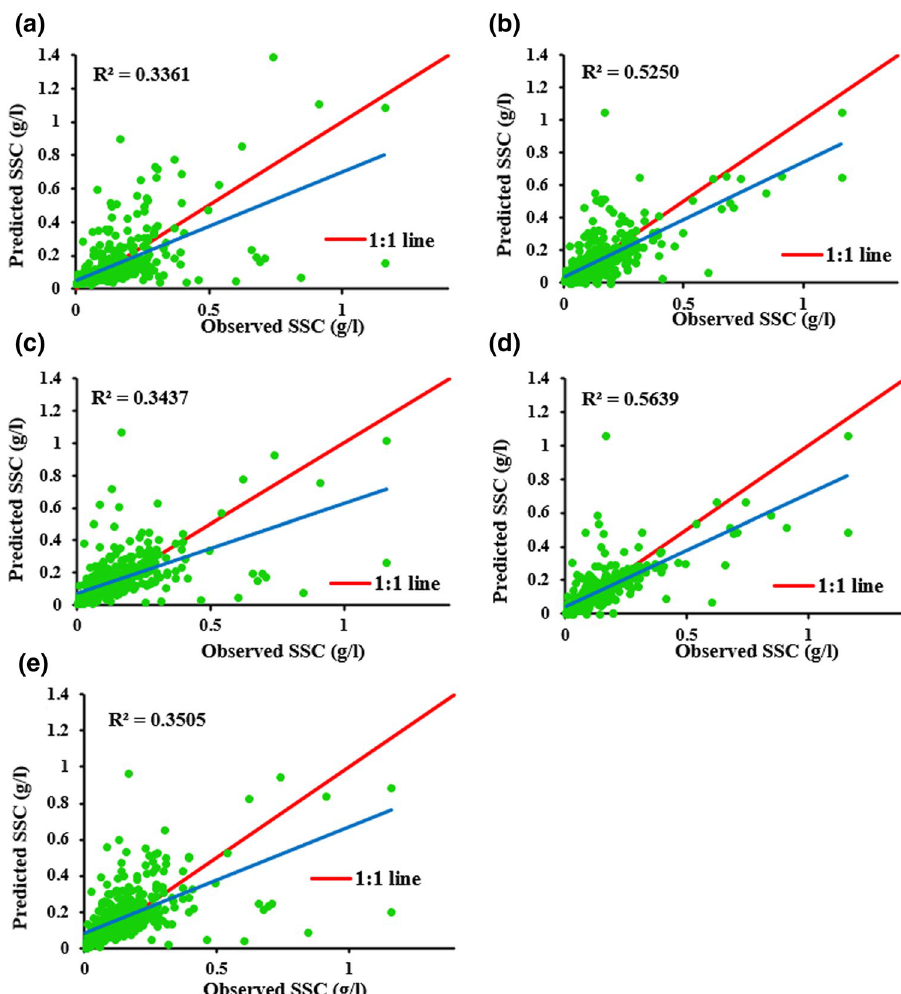
Fig. 11 Scatter plots of devel- oped models a ANN, b WANN,